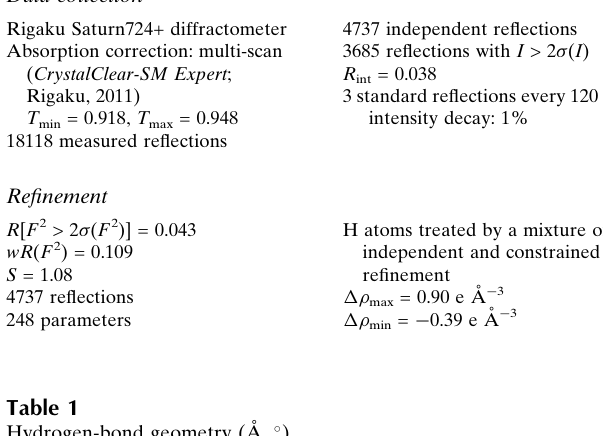
Hydrogen-bond geometry (A˚ , (cid:2)